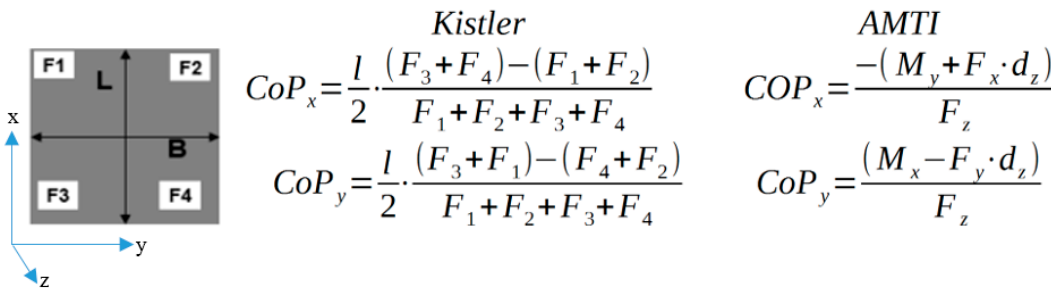
Figure 1. Formulas for the calculation of the center of pressure depending on the utilized measurement parameters. (F1–F4, F z = force in Z direction (N); L = length of the force plate (cm); B = width of the force plate (cm) M y = Moment in y direction; M x = Moment in x direction) [3,18].